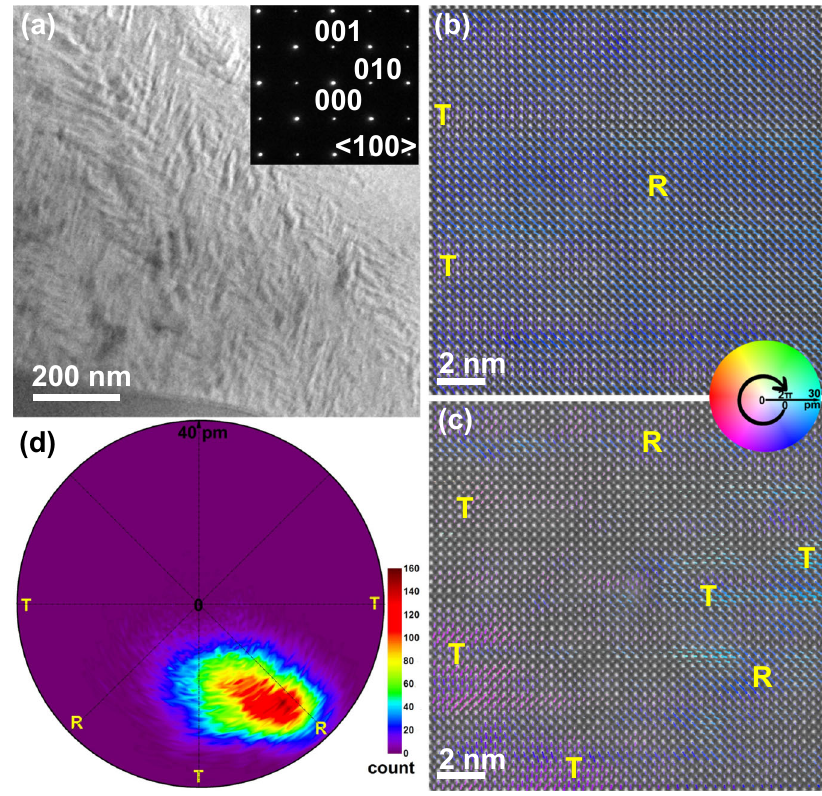
Fig. 3 | Local structure information of PNRs. a Bright- fi eld TEM image and SAED pattern and b , c atomic-resolution HAADF STEM polarization mappings measured atdifferent regions along < 100> c direction for PL 8.3 Z 66 T 34 ceramic. d The statistics